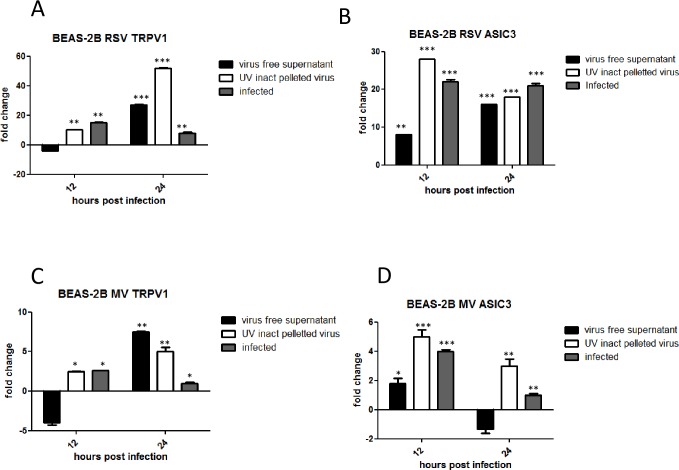
TRPV1 and ASIC3 mRNA levels are up-regulated by virus-induced soluble factors and UV inactivated pelleted virus.BEAS-2B cells were infected with RSV (MOI 0.1) and MV (MOI 1) or treated with virus free supernatant, supernatant from mock infected BEAS-2B cells or UV inactivated pelleted virus. TRPV1 and ASIC mRNA levels were quantified by qRT-PCR. (A) RSV; TRPV1, (B) RSV; ASICS3 (C), MV; TRPV1 (D) MV; ASIC3. Data is presented as relative fold change to TRPV1 and ASIC3 mRNA levels in uninfected/untreated control cultures.